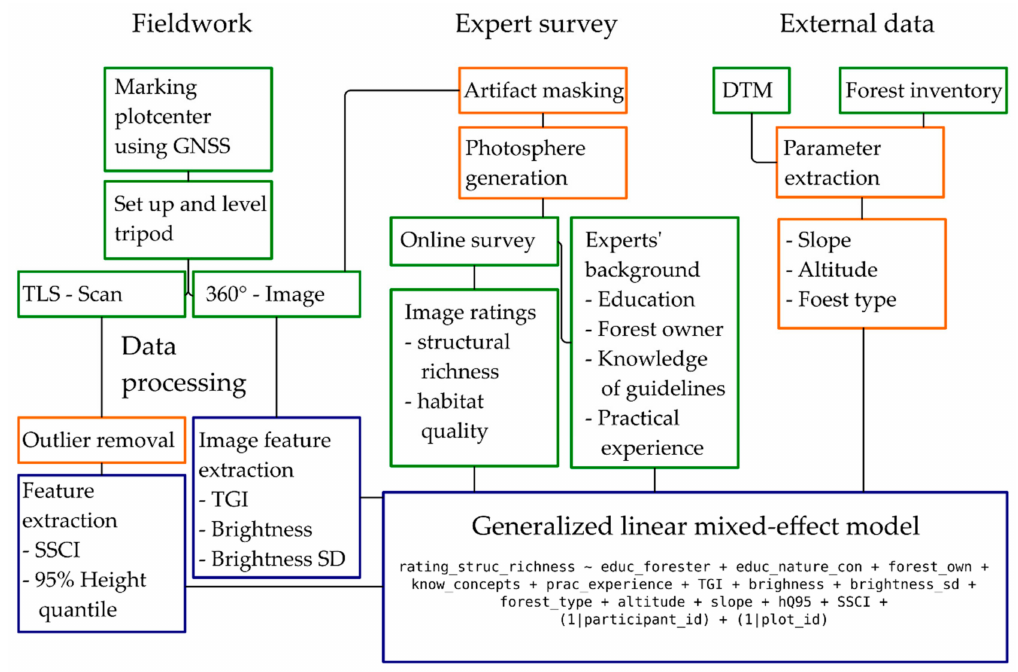
Figure 1. Detailed workflow of the whole study. Details about the processing steps can be found in chapters 2.2–2.6. Green boxes indicate data acquisition, orange boxes data preparation and blue boxes data analysis steps. DTM stands for digital terrain model, TGI for triangular greenness index and brightness standard deviation (SD) for the area weighted standard deviance of the image